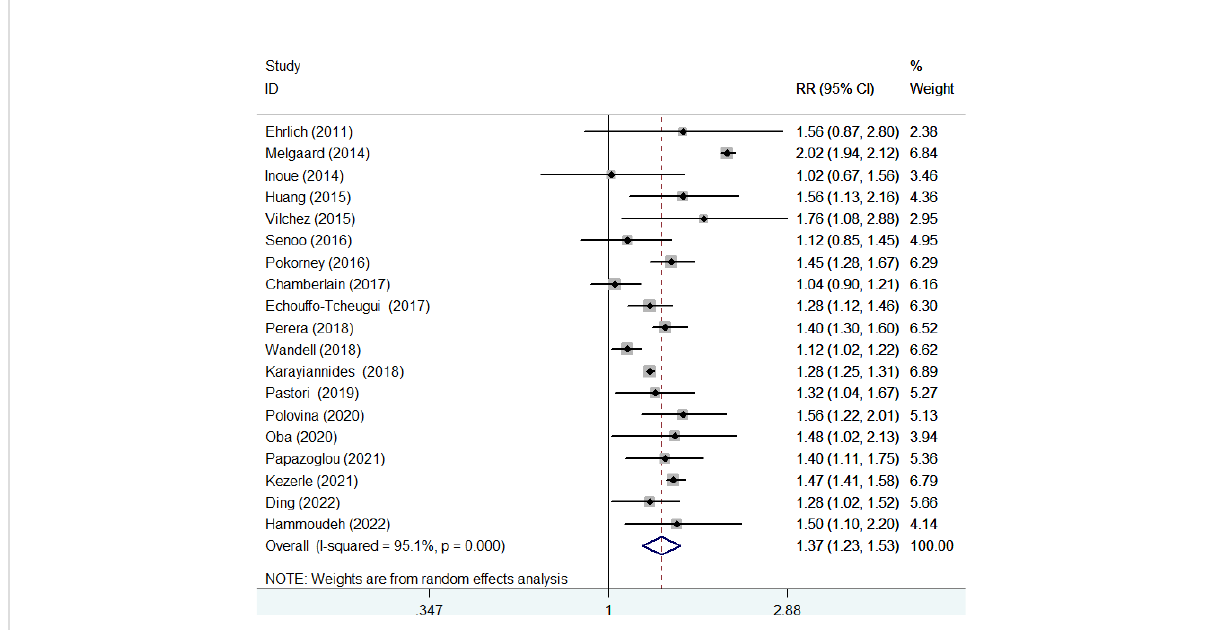
FIGURE 3 Forest plot showing the pooled risk ratio (RR) with 95% CI of all-cause mortality for those with diabetes versus those without